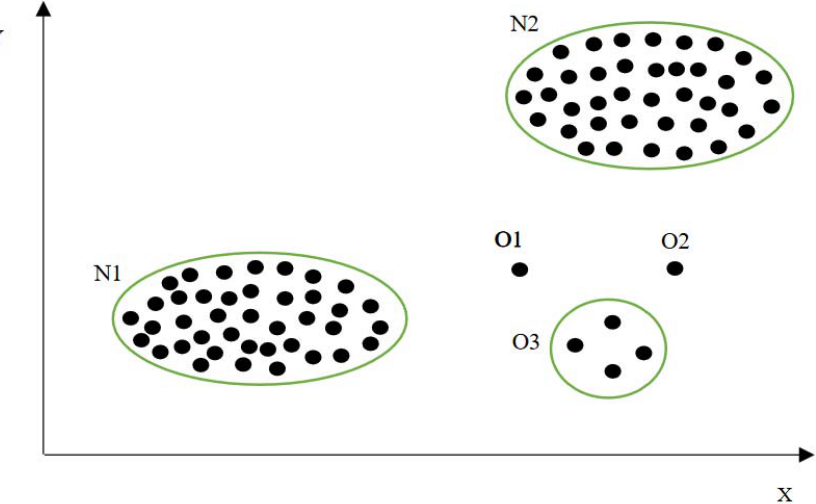
Figure 5. An example of an anomaly in 2D (two ‐ dimensional space) where “O1” and “O2” are point anomalies, “N1” and “N2” are collective anomalies, and “O3” is a collective anomaly. (b) Context (b) Context Anomaly